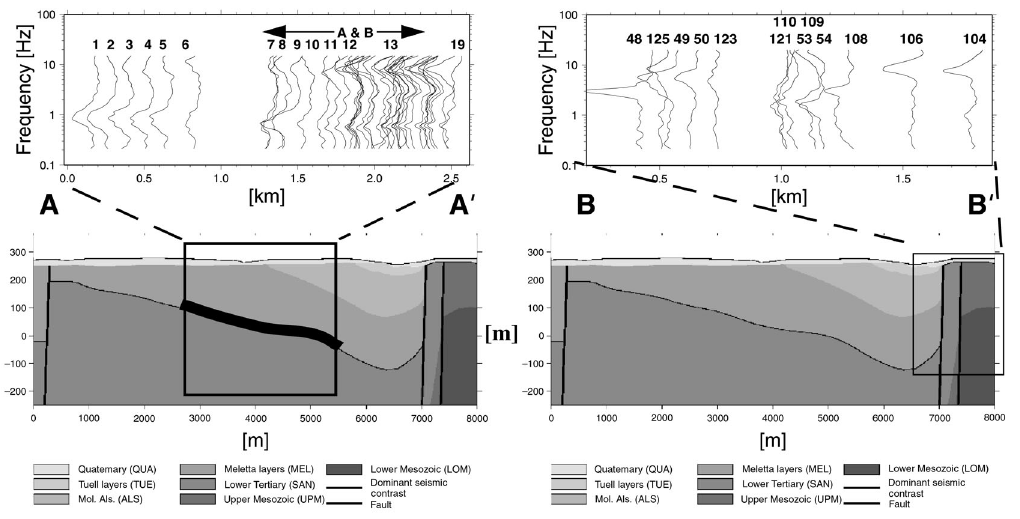
Fig. 4. Spatial evolution of spectral H / V ratios along profile A-A ′ (profile stations and stations from array A and B) and B-B ′ . The averaged H / V spectral ratios were plotted for each individual site where the abscissa of the diagrams corresponds to the relative distances between the stations projected onto the profile axis . The geolog- ical profile was modified after Kind (2002). The length and position of the boxes in the profile show the ap- proximate H / V measurement locations.